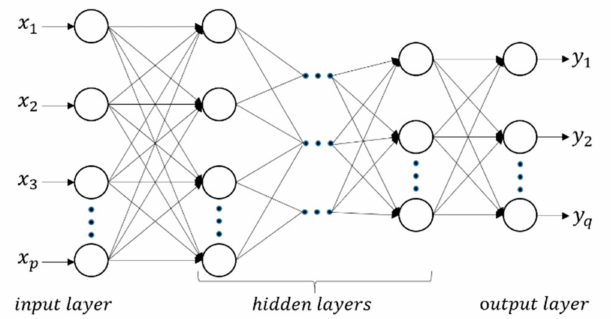
Figure 1. The structure of neural